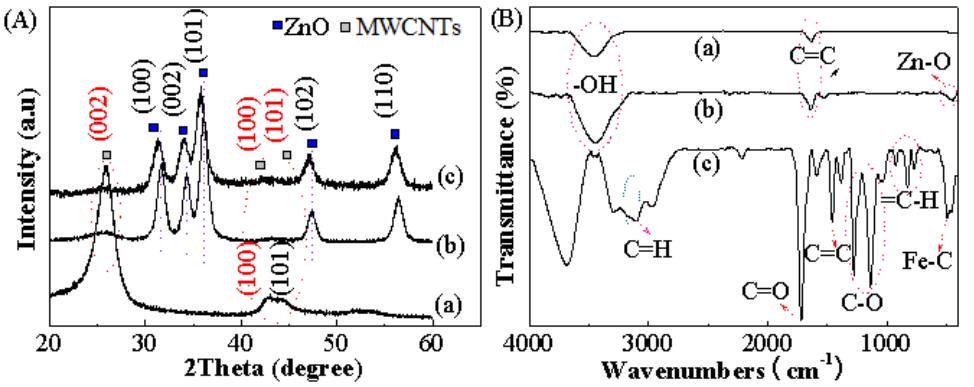
Figure 1. XRD patterns ( A ) and FTIR spectra ( B ) of ( a ) MWCNTs, ( b ) MWCNTs@ZnO, and ( c ) MWCNTs@ZnO /